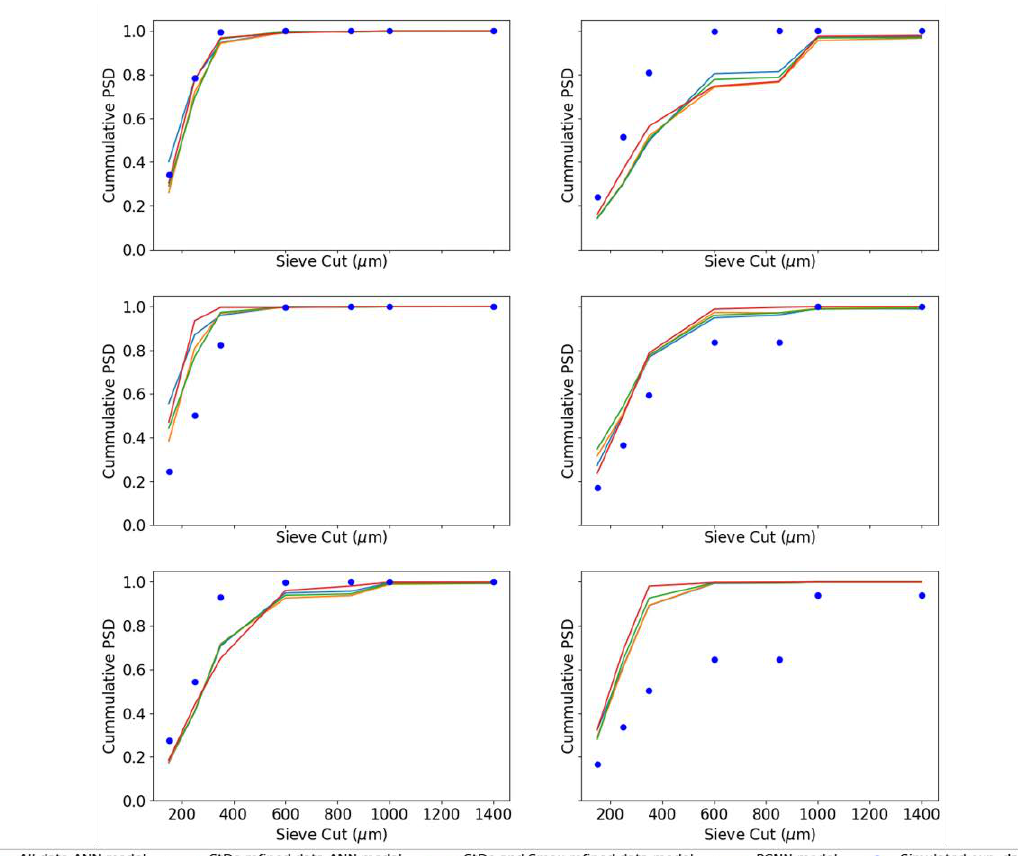
Figure 3. Each subplot corresponds to one simulated experimental result and the four model predictions are compared in the plot. A toal of six points at random were chosen for this plot from the test data set for comparison. The blue solid line represents the model prediction for the pure ANN model, the yellow line represents the model prediction for the St def refined data model, and the green line represents the model prediction of the St def and S max . The blue solid line represents the prediction for the PCNN model. The blue dots represent the simulated experimental results. The performance of all four models seems to be